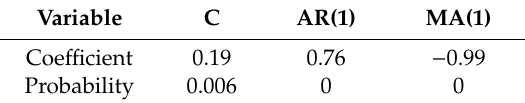
Table 9. Model parameters of ARIMA (1,1,1).